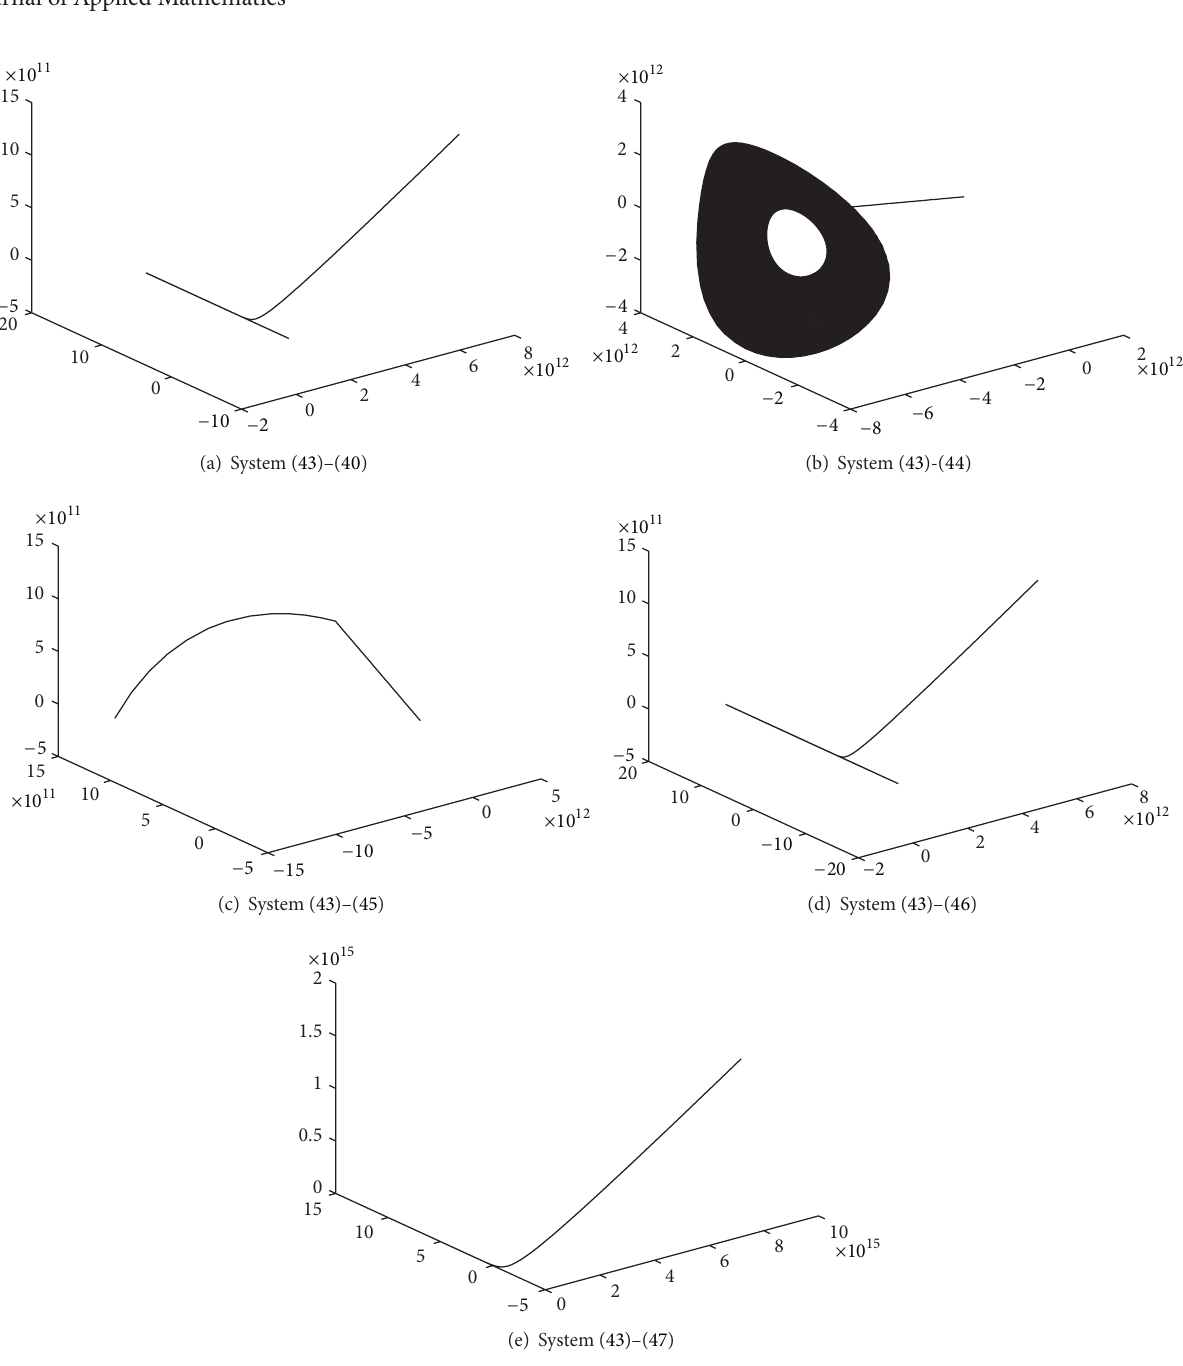
Figure 8: Switched system between system (43) and